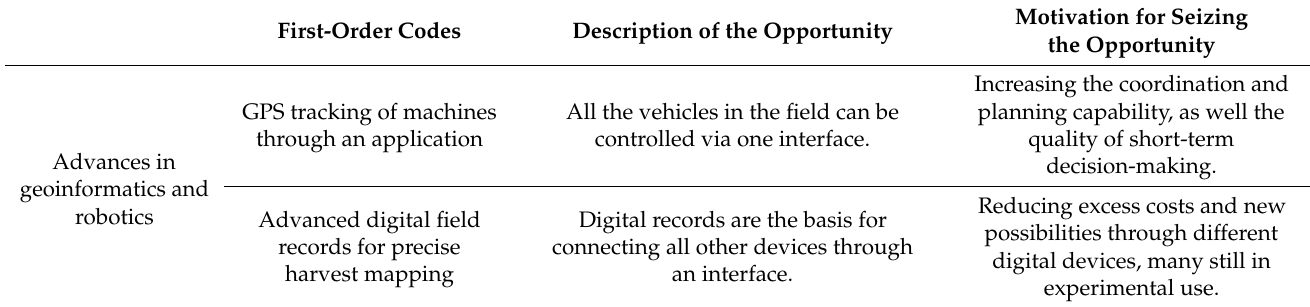
Table A2. Push strategies for adoption of new grape harvest technology with detailed descriptions and motivations for seizing the